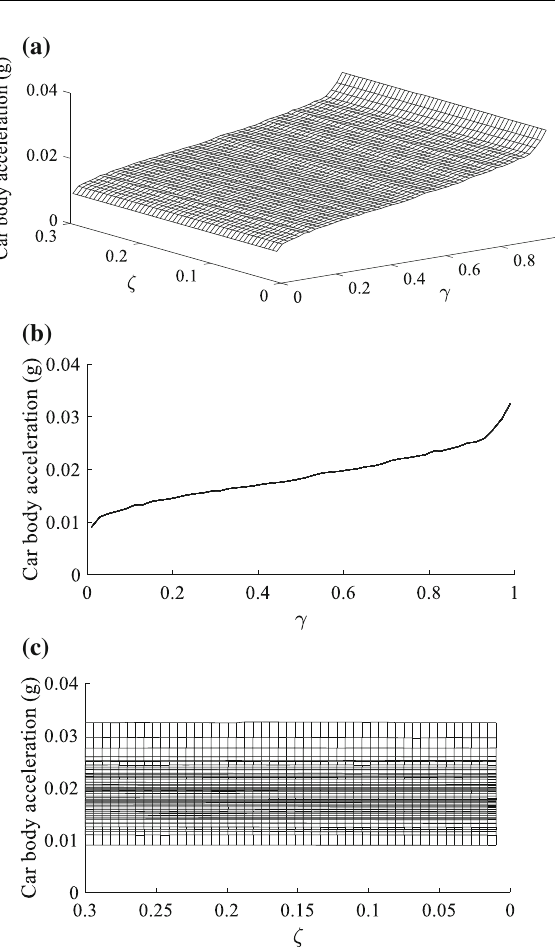
Fig. 16 Car body vertical acceleration against the changes of track irregularity probability level c and parameter COV f ( a 3D view; b side view; c end view)